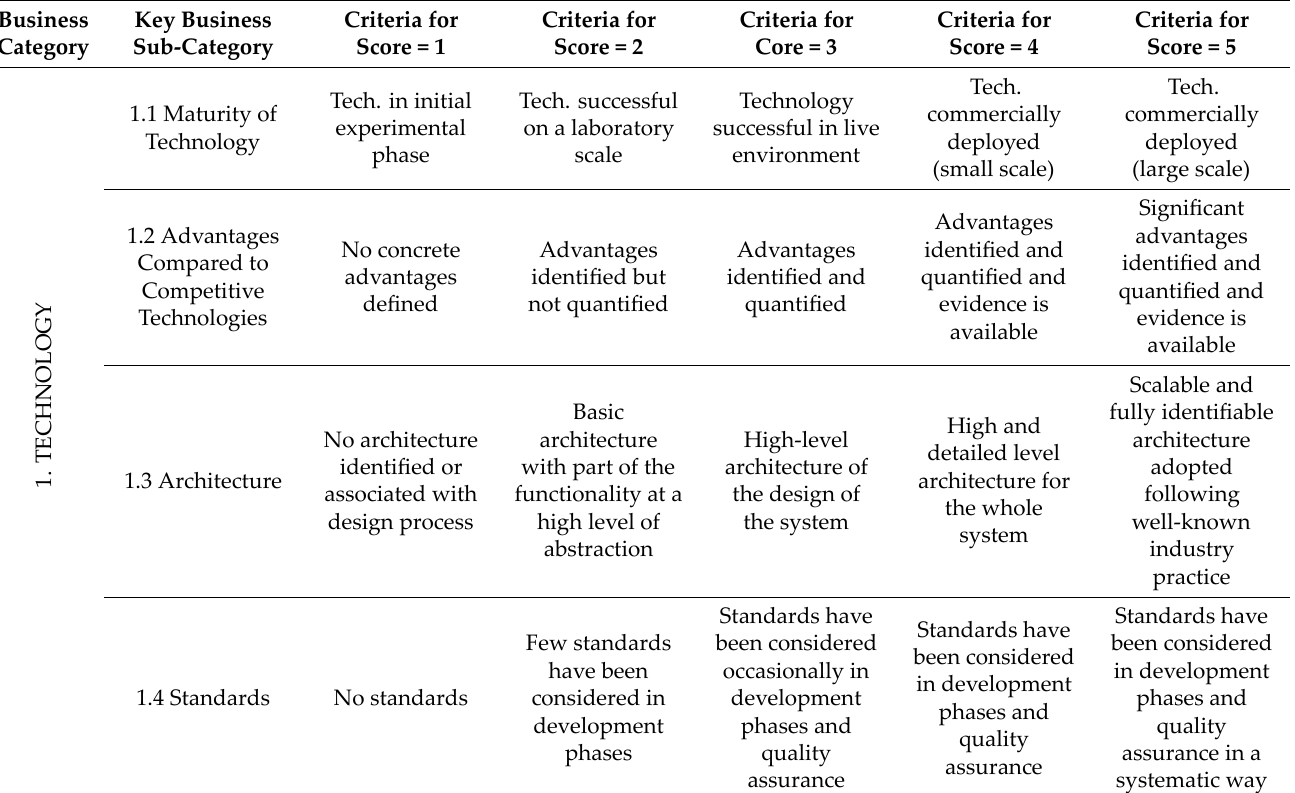
Table A1. Assessment